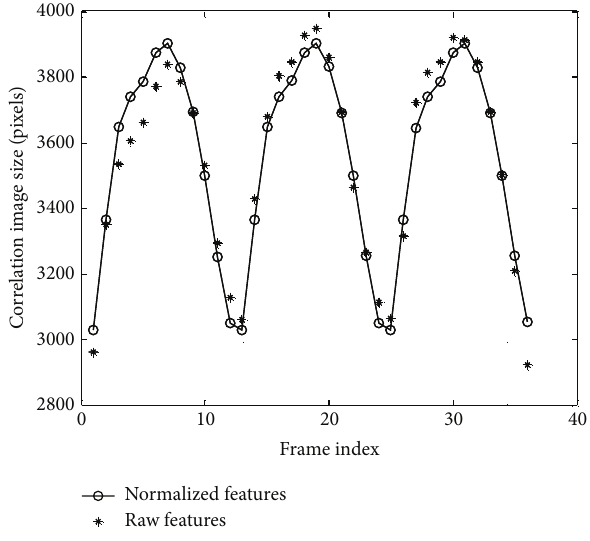
Figure 5: Correlation image size calculated by raw features and by normalized